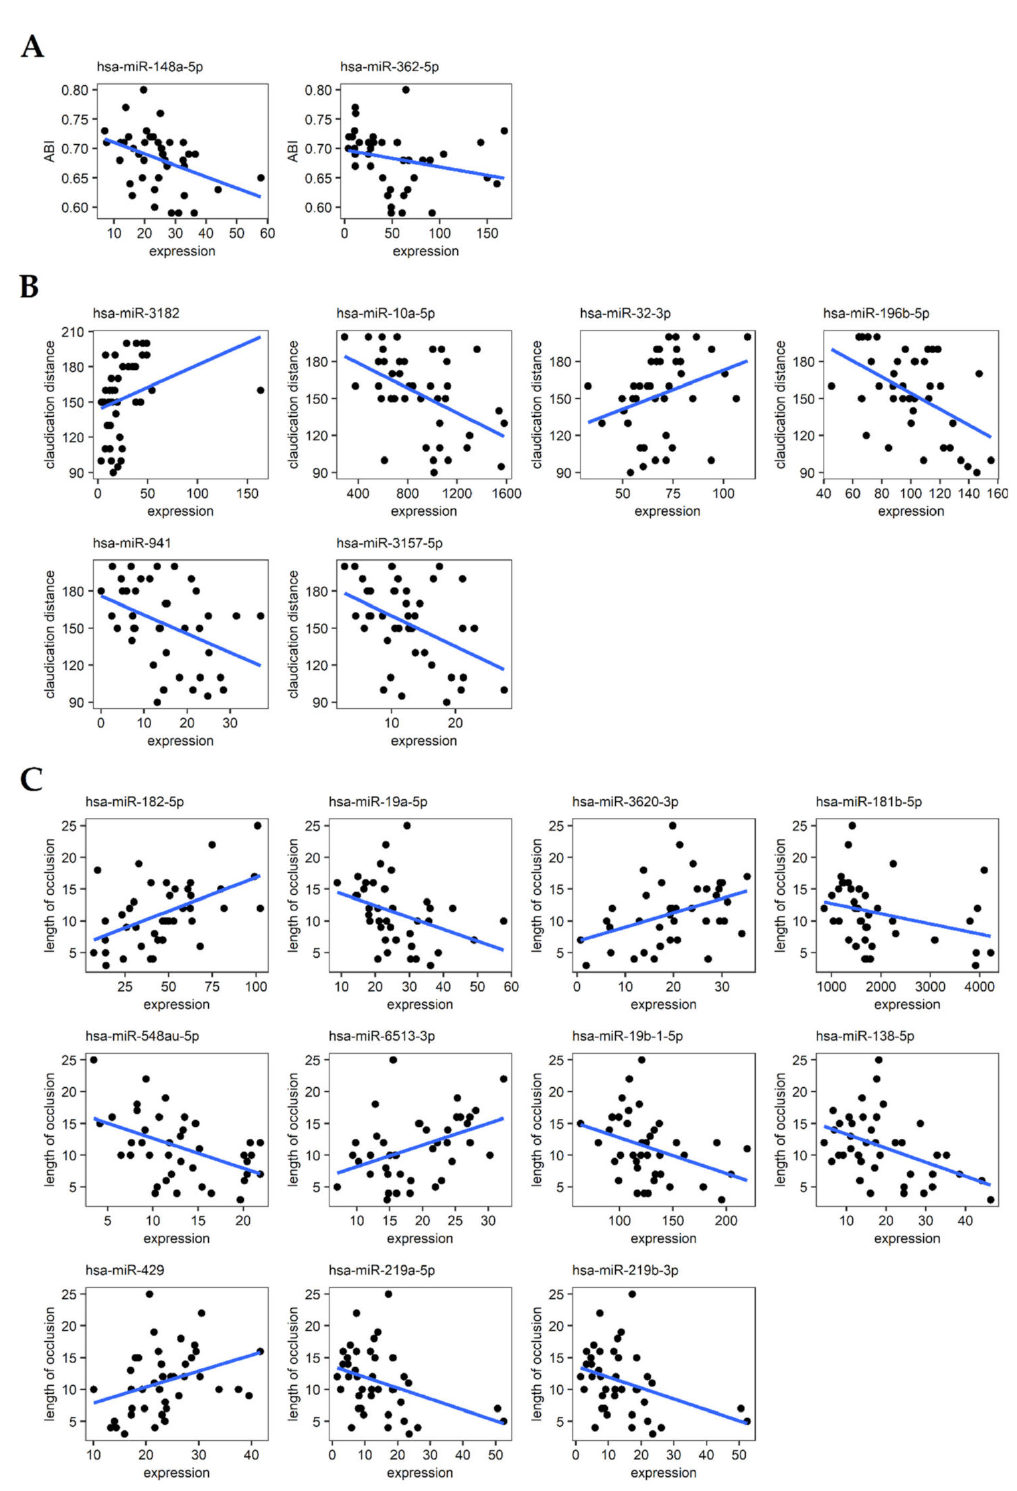
Figure 1. Scatter plots depicting correlations between 19 selected miRNAs and clinical parame- ters of LEAD progression including ( A ) ankle brachial index (ABI), ( B ) claudication distance, and ( C ) length of arterial occlusion. Blue lines indicate the trend line (fitting line of the simple linear regression